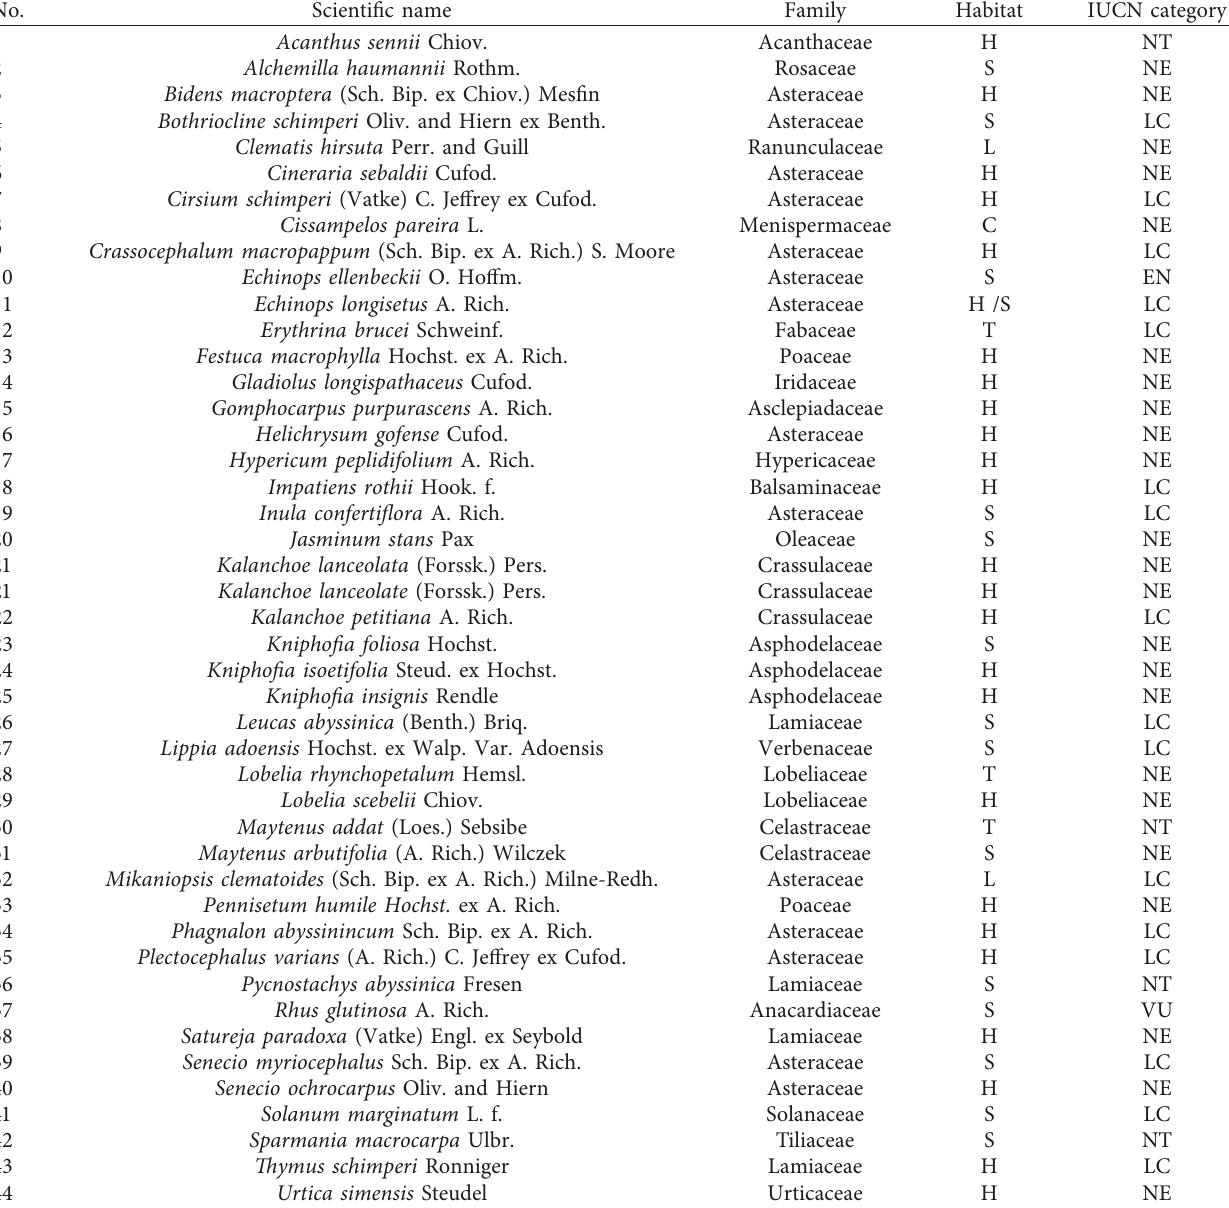
a indicates growth forms of the plants, H is the herb, T is the tree, S is the shrub, L is the liana, and C is the